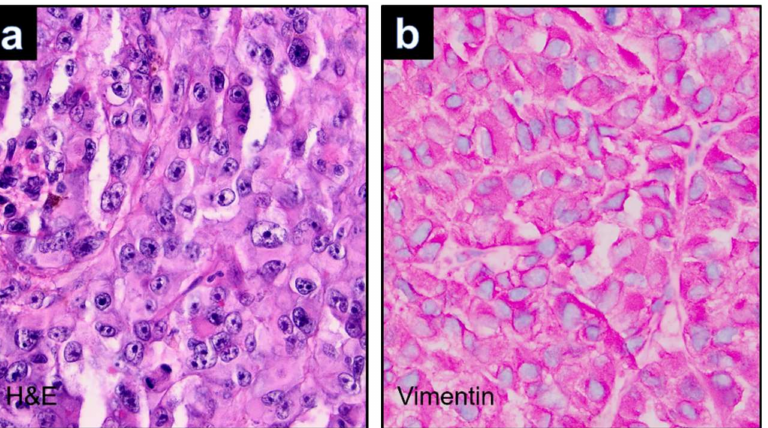
Figure 1. ( a ): Rhabdoid melanoma cells exhibit eosinophilic cytoplasm displaying a round eccentric vesicular nucleus with a prominent central nucleolus and large intracytoplasmic hyalin inclusions (Hematoxylin&Eosin (H&E), × 400). ( b ): Vimentin is expressed in the intracytoplasmic inclusions (Vimentin, ×